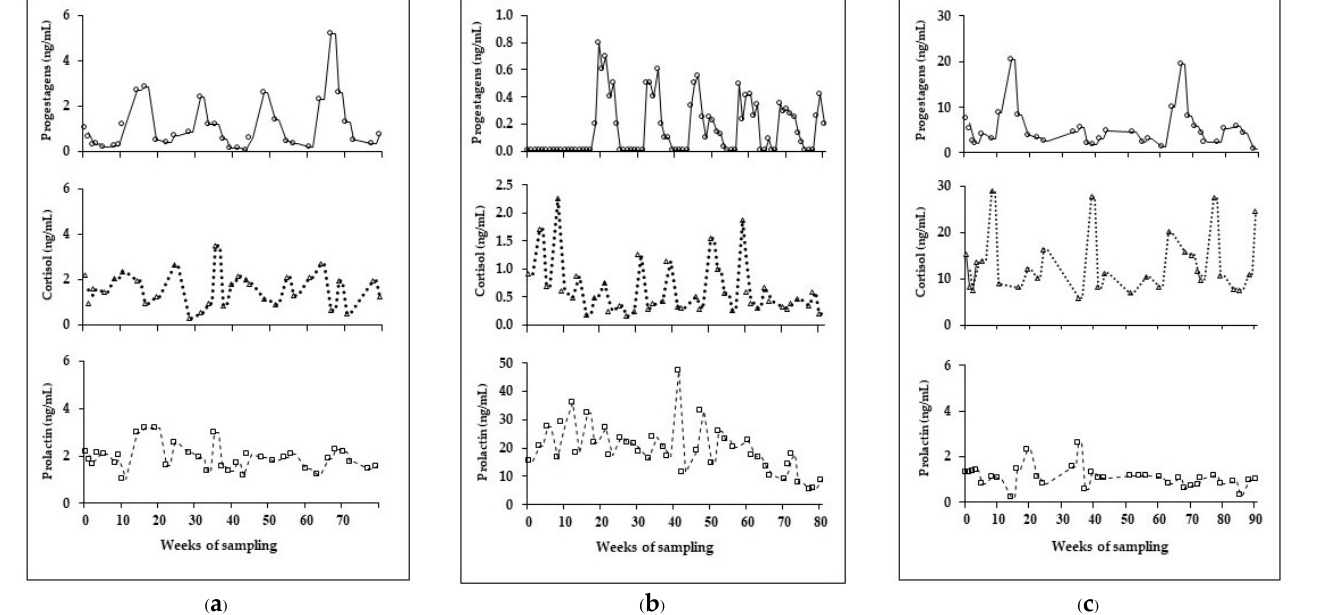
Figure 2 . Individual profiles of serum progestagen, cortisol, and prolactin concentrations in ( a ) normal Figure 2. Individual profiles of serum progestagens, cortisol, and prolactin concentrations in ( a ) nor- cycling elephant ( E9 ) ; ( b ) cycling elephant with elevated concentrations of prolactin ( E5 ) ; and ( c ) cycling mal cycling elephant (E9); ( b ) cycling elephant with elevated concentrations of prolactin (E5); and elephant with elevated cortisol ( E6 ). ( c ) cycling elephant with elevated cortisol Table 3 . Individual mean ( ± SEM ) progestagen, cortisol, and prolactin concentrations in pregnant and cycling elephants .